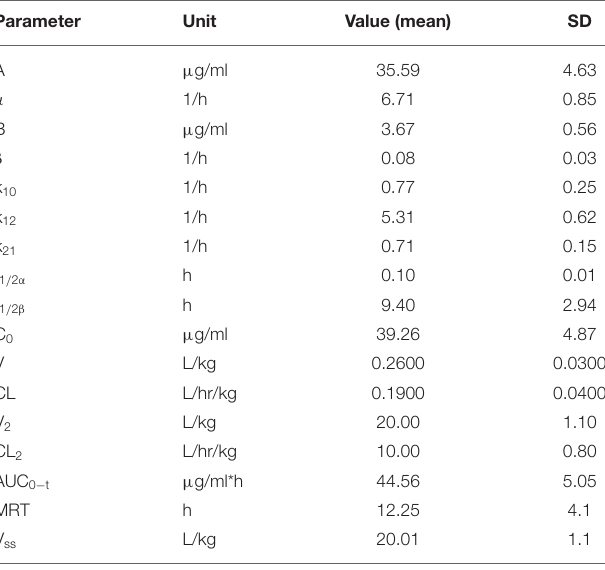
TABLE 1 | The pharmacokinetic parameters for acepromazine (0.1 mg/kg) after intravenous administration in camels ( n = 6).